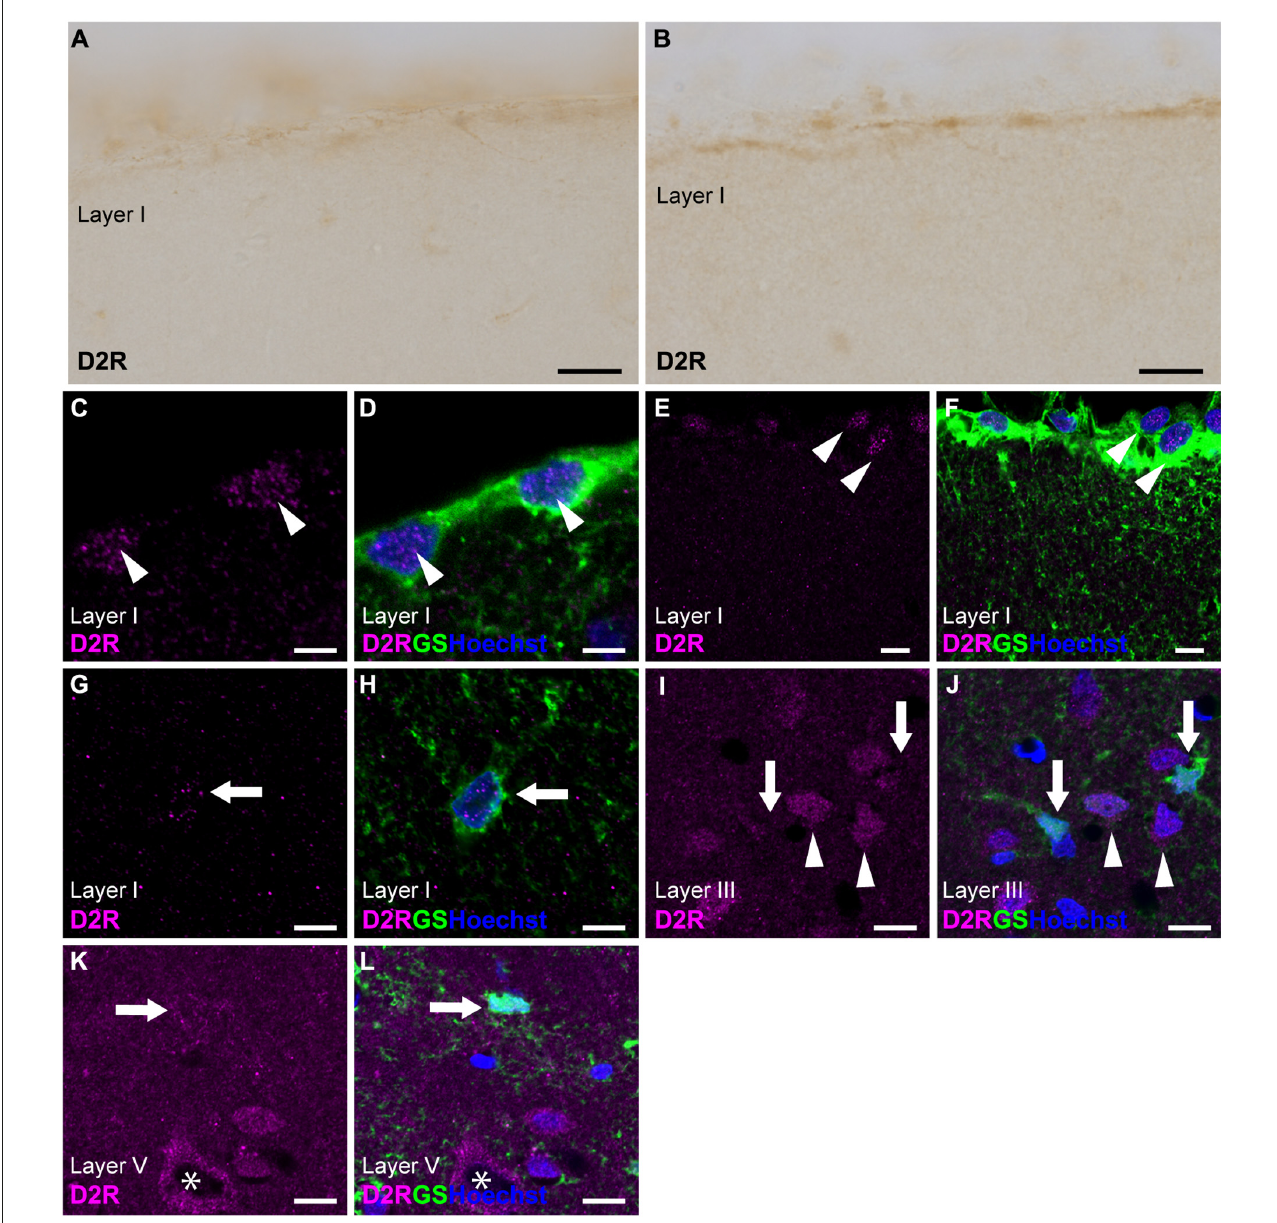
FIGURE3 D2R-immunoreactivity in astrocytes. (A,B) Very weak immunoreactivities for D2R were observed in the pial surface of the prelimbic (A) and somatosensory (B) areas. (C,D) Confocal imaging of double immunostaining for D2R (magenta) and GS (green) indicated a few weak D2R-immunoreactivities in pial astrocytes (arrowheads) in the prelimbic area. (E,F) Confocal imaging of double immunostaining for D2R (magenta) and GS (green) indicated weak D2R-immunoreactivities in pial astrocytes (arrowheads) in the primary motor area. (G,H) Weak D2R-immunoreactivities were observed in layer I astrocytes (arrowheads) in the somatosensory area. (I,J) In layer III of the primary motor area, D2R-immunoreactivities (magenta) were observed in GS-negative cells (arrowheads), but not in GS-positive protoplasmic astrocytes (arrows). (K,L) In layer V of the primary motor area, D2R-immunoreactivities (magenta) were observed in GS-negative cells (asterisk), but only very weak in GS-positive protoplasmic astrocytes (arrows). Nuclei were stained with Hoechst33342. Scale bars: 20 µ m (A,B) ; 5 µ m (C,D) , 10 µ m (E–L)